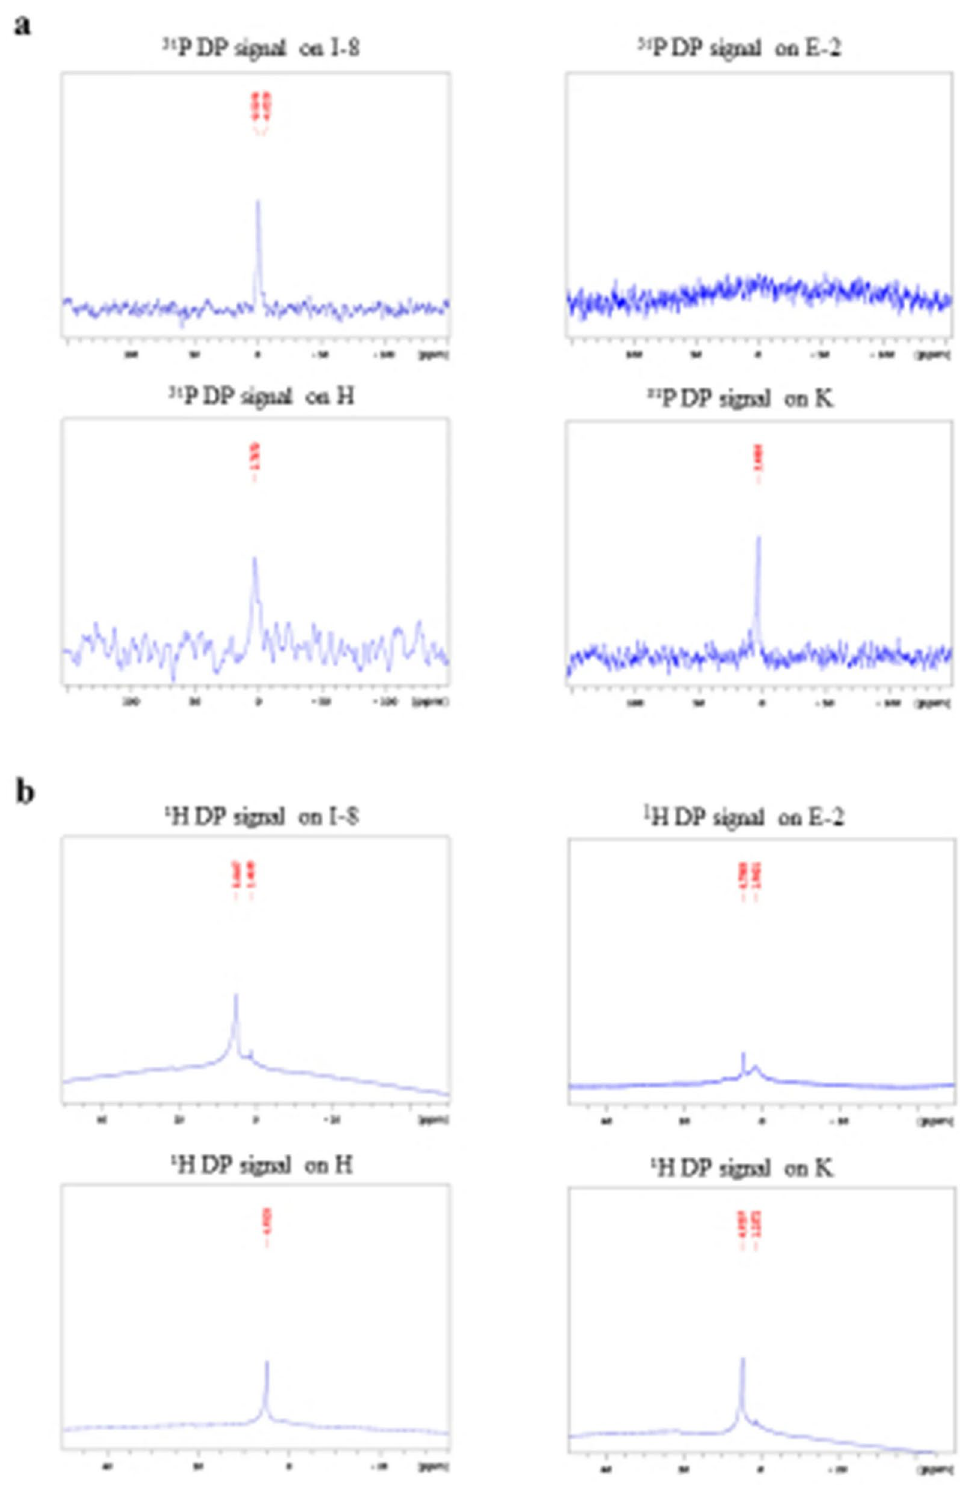
Figure 4. Solid state NMR results: I-8 representative sample from Te’omim cave, Israel; E-2 representative sample from Egypt; H from Herodium bathtub; K from Kypros bathtub. ( a ) 31 P NMR data. ( b ) 1 H NMR